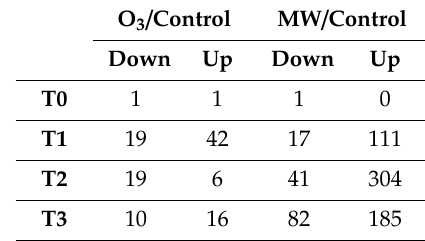
Table 1. Number of di ff erentially-accumulated metabolic features (DAMFs) for the O 3 (250 ppb) and MW treatments in comparison to the control plant. The DAMFs are categorized according to the sampling time (T0–T3), the treatment (O 3 and MW), and their accumulation (up) / depletion (down). The DAMFs were identified from a one-way analysis of variance (ANOVA, p < 0.05, Fisher’s least significant di ff erence (LSD) post hoc test). The detailed list of all metabolic features and DAMFs is available in Supplemental Data 3. O 3 / Control MW / Control Down Up Down Up